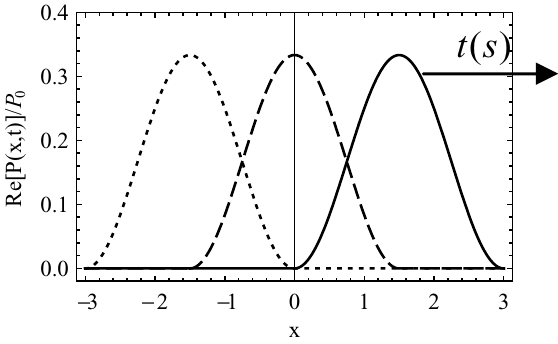
Fig. 3. Distributed load for V = 50 m/s, r = 3/2 m and Ω ≈ 0. ( k, ω )= ˆ P ( k, ω )( 0